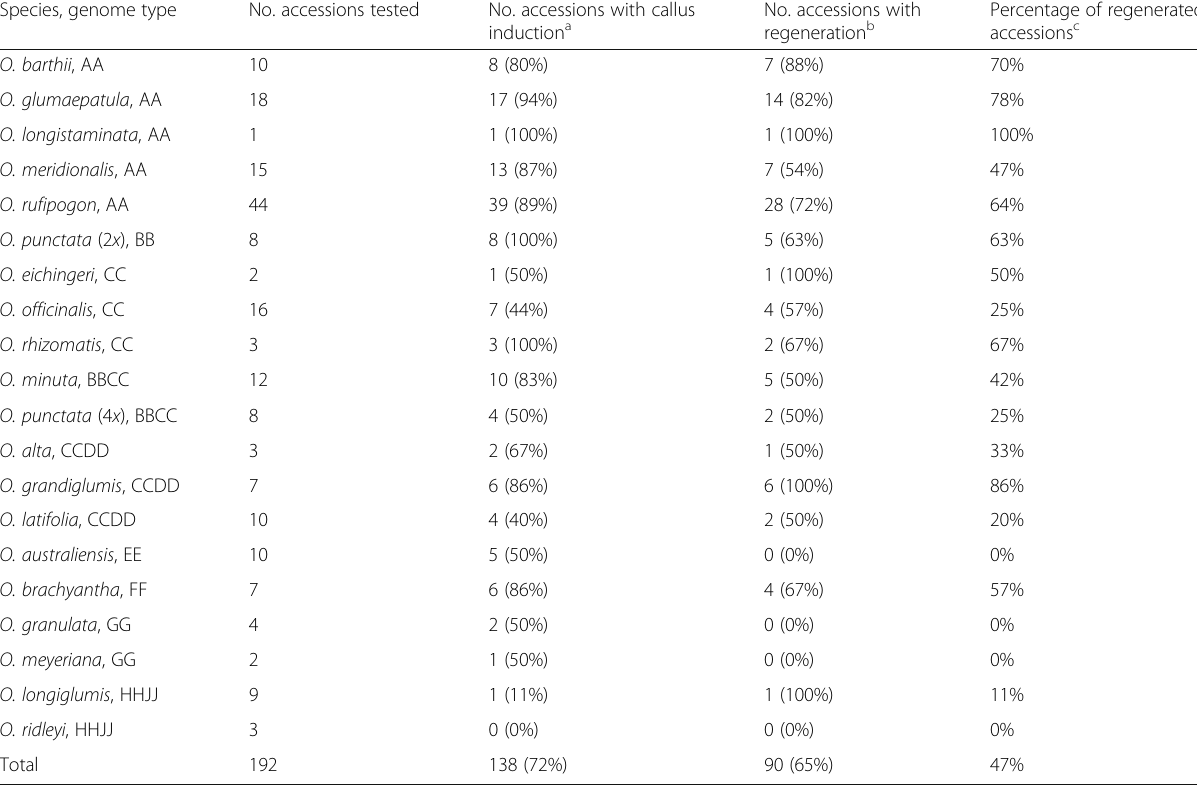
Table 3 Summary of regeneration tests from immature embryos of wild Oryza species Species, genome